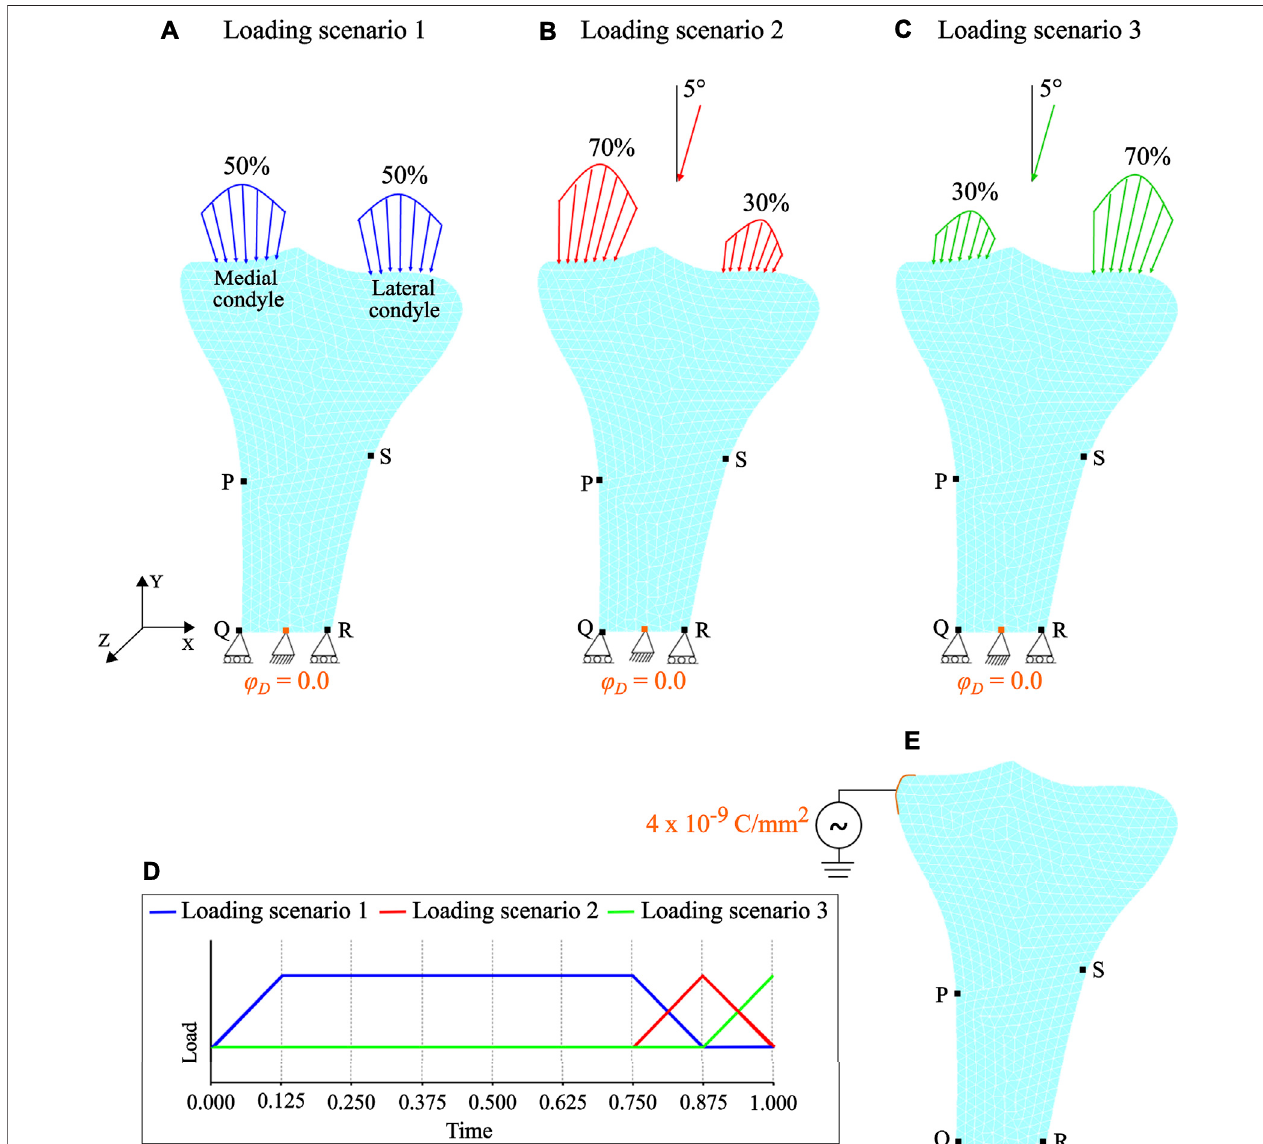
FIGURE4| Loadingandboundaryconditions: (A) loadingscenario1 (B) loadingscenario2,and (C) loadingscenario3.Markthatforloadingscenarios2and3,the jointreactionforceisinclinedby5 + totheverticaldirection. (D) Loadingpatternappliedindependentlyandsequentially. (E) Therapeuticelectricalstimulationintheformof surface electric charge applied to the lower end of the medial condyle during the period of reduced physical activity. Note that the electrical boundary conditions are highlighted in orange.